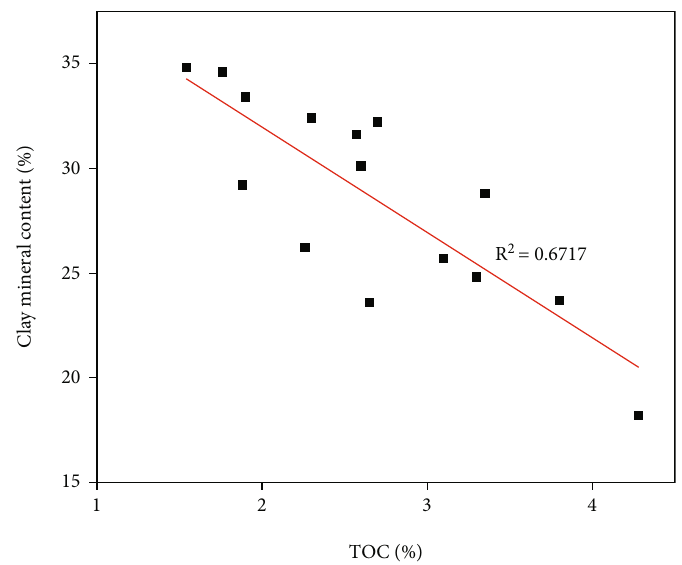
Figure 21: Relationship between clay mineral content and the